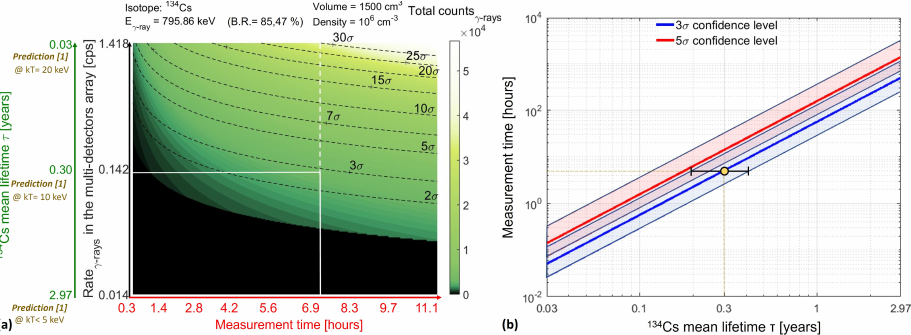
Figure 4. (a) Confidence levels that it is possible to obtain after a given t meas , reported on the x axis, vs the decay-rate (or the lifetime) of 134 Cs. (b) - Iso-significance level at 3 σ and 5 σ reached after a given measurement time, reported on the y axis, versus the decay-rate (or the lifetime) of the 134 Cs isotope.